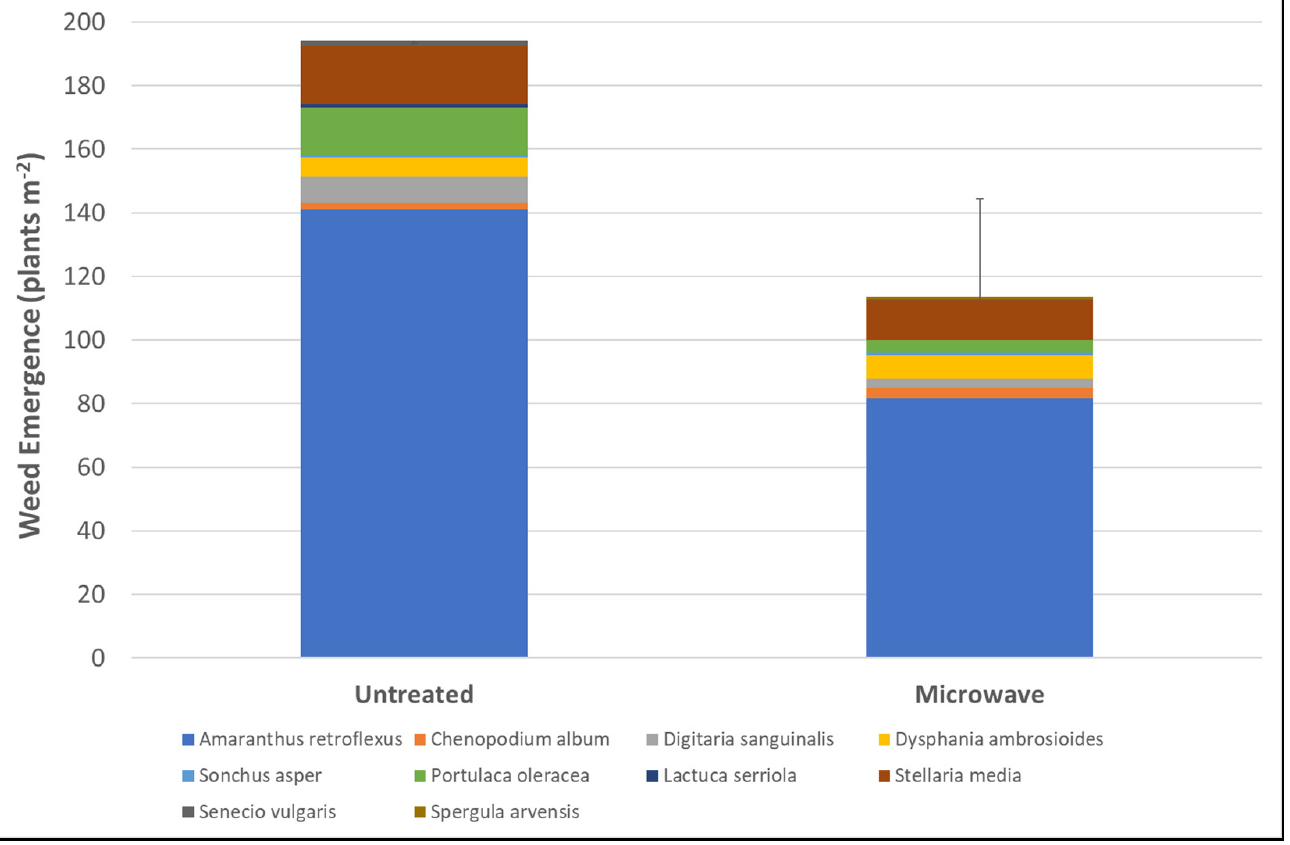
Figure 4. Weed emergence in soils treated with microwave or an untreated control in field Experiment 1 (16/17) in the strawberry runner sector. The bar is the LSD where p = 0.05. Table 4. Concentrations of DNA of Pythium spp. (clades I and F) in soil (Log10 pg DNA g − 1 soil) at different depths following treatment with microwave in two field experiments. Runner Yield Runner Year Treatment m − 1 of row